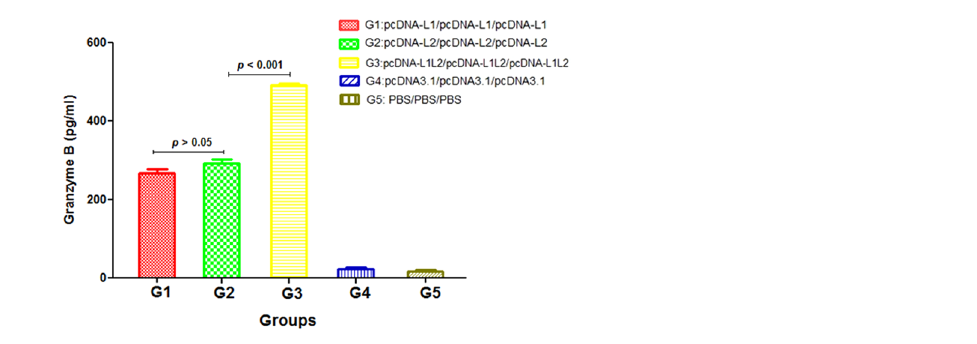
Figure 8. Granzyme B concentration measured by ELISA using the pooled splenocytes from three mice in each group (n = 3 per group). All analyses were performed in triplicate for each